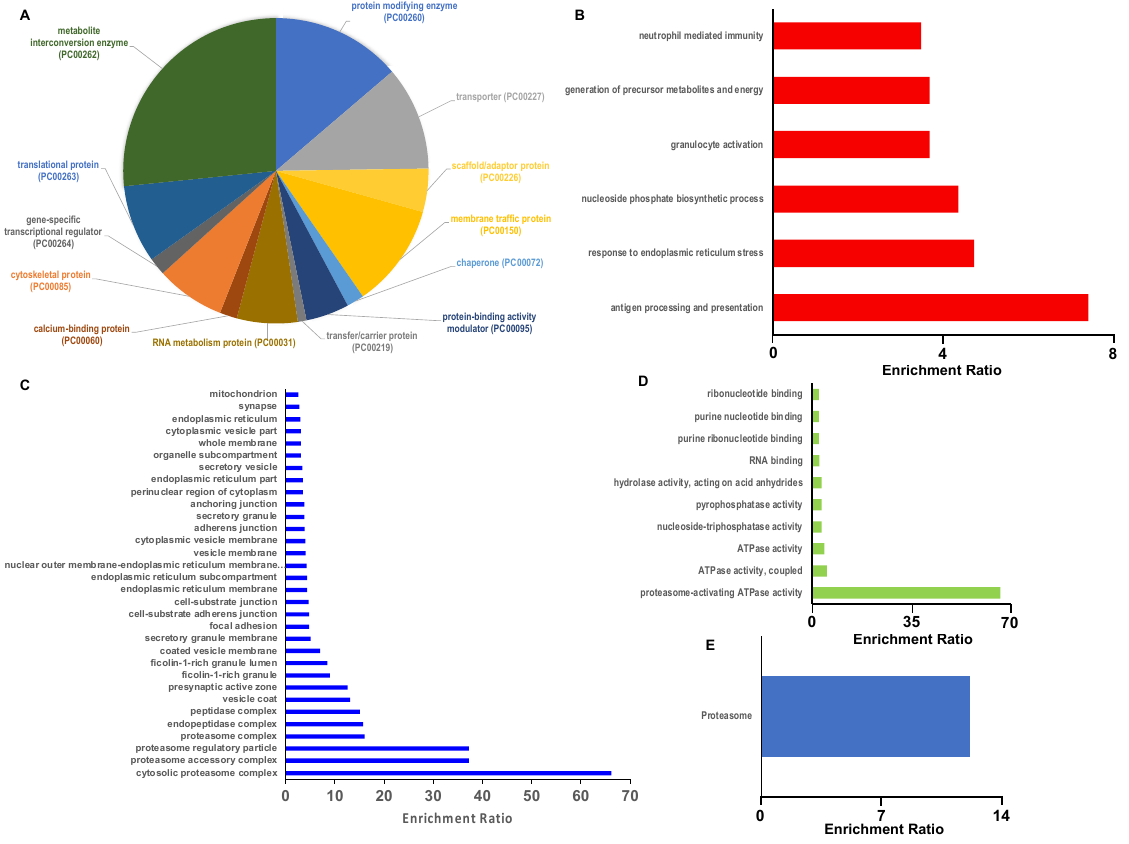
Figure 8. Bioinformatic characterization of HLMVEC proteins modified by 2-ClHDyA: ( A ) Dis- tribution of 2-ClHDyA-modified proteins by protein class analyzed using Panther; ( B – E ) Over representation analysis using the Web-based Gene Set Analysis Toolkit (WebGestalt). Enriched categories in Gene ontology (GO) Biological function ( B ); Cellular component ( C ); Molecular function ( D ); and KEGG Pathway using Bonferroni p < 0.05 for computing FDR ( p < 0.05) ( E ).